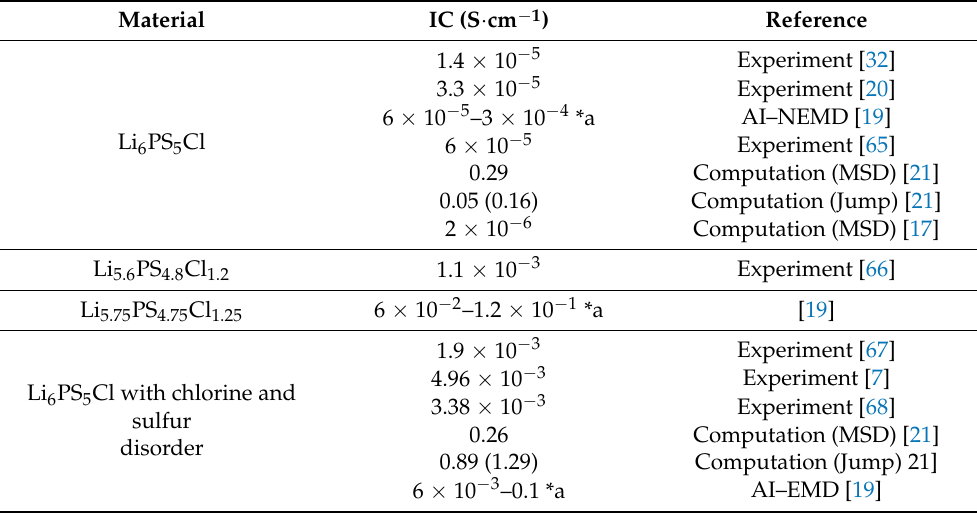
Table 4. The conductivity of Li 6 PS 5 Cl and defective materials at 300 K investigated in tens of research and computational